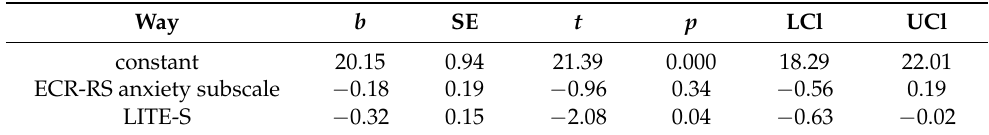
Table 4. Linear regression between attachment anxiety in relation to mother and acquired capability for suicide.